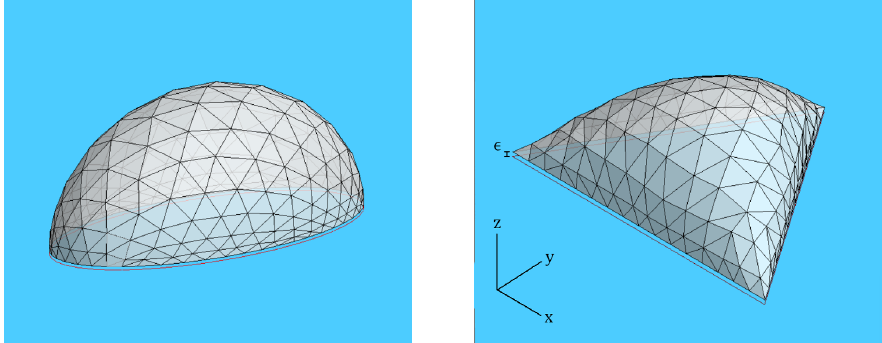
Figure 13. Approximate minimal surfaces for an ellipse and triangle in CFT 3 . The elliptical boundary is defined by x 2 / 4 + y 2 = 1 and the triangle has side length holographic direction z points upward. The boundaries of the entangling regions are shown in red, and the surfaces are cut off at separation (cid:15) = 0 . 03 above them. The triangulation on these surfaces is purposefully rough to demonstrate the process used by the